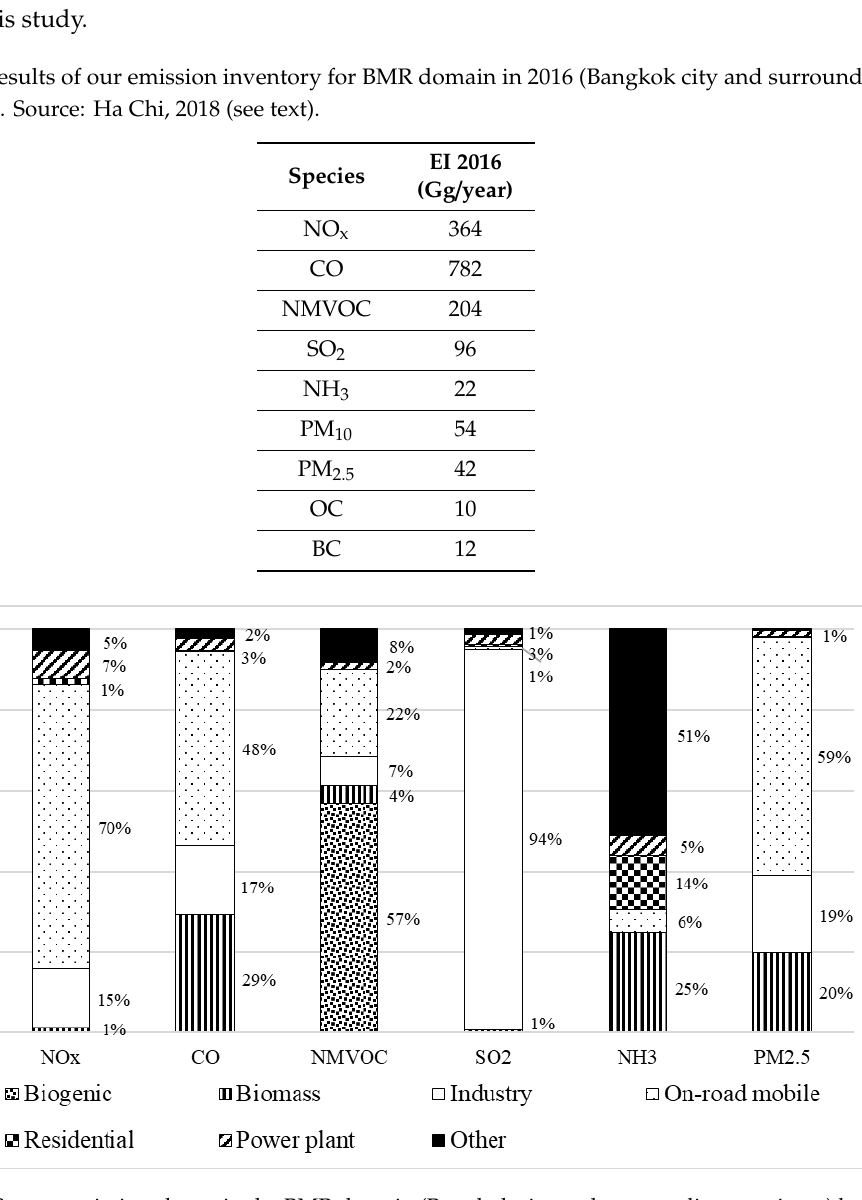
Figure 2. Source emission shares in the BMR domain (Bangkok city and surrounding provinces) based on our emission inventory data. Table 3. Results of our emission inventory for BMR domain in 2016 (Bangkok city and surrounding provinces). Source: Ha Chi, 2018 (see text).